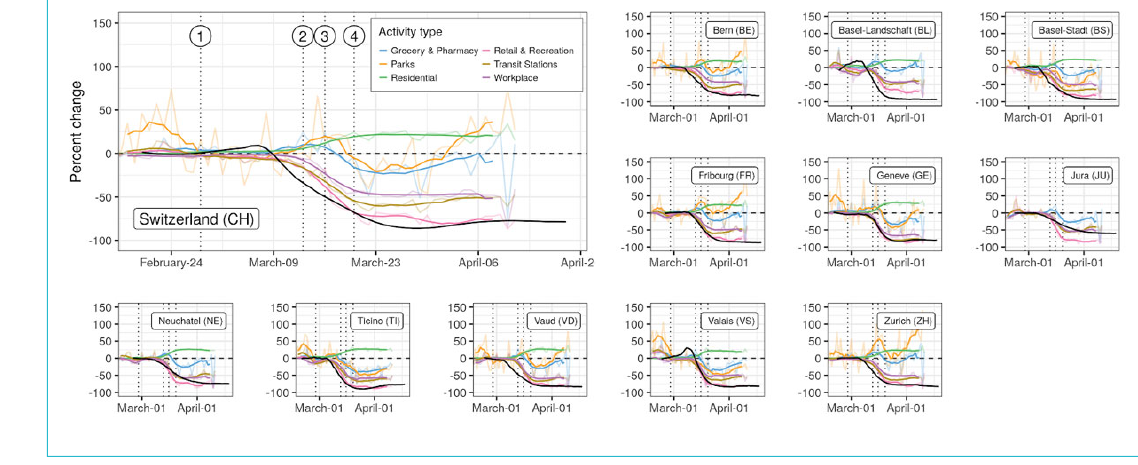
Figure 3: Changes in mobility patterns and R 0 . Changes in mobility with respect to baseline are shown by activity type in terms of the daily values (transparent lines) and 7-day rolling mean (full lines), against the median estimate of R 0 (black line). Vertical dotted lines indicate the is- suing of NPIs: (1) ban on gatherings of more than 1000 people, (2) school closure, (3) closure of non-essential activities, and (4) ban on gath- erings of more than five